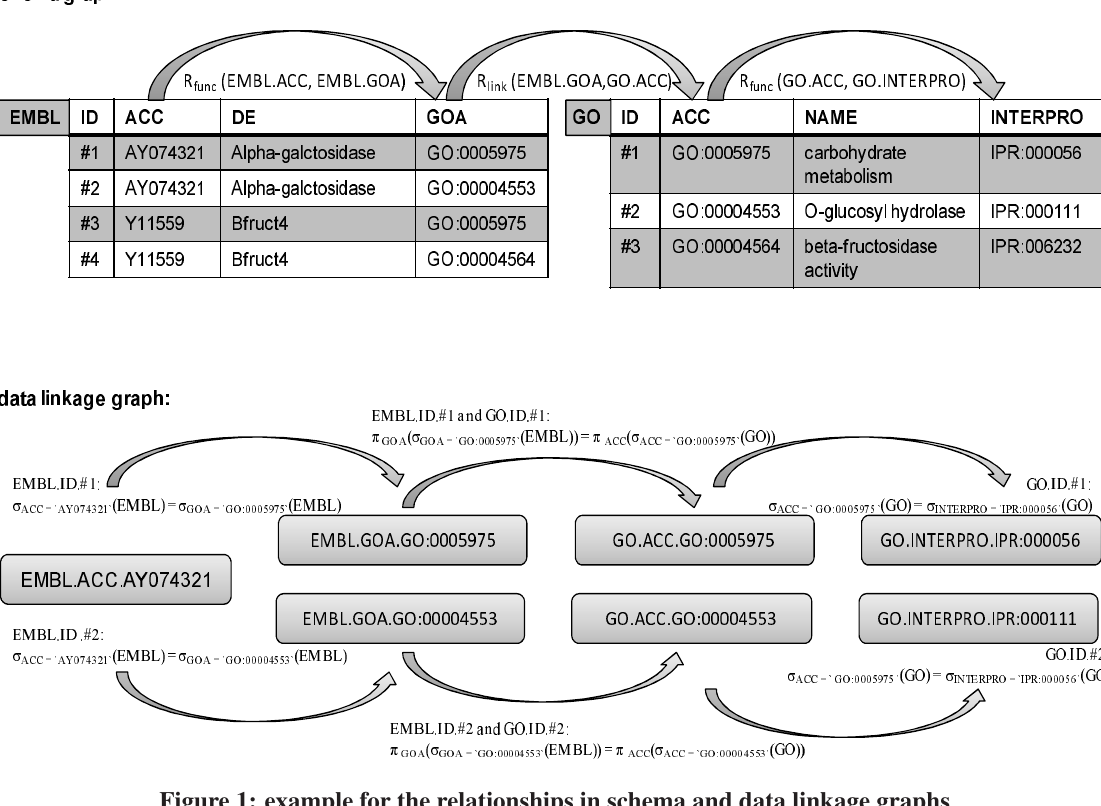
Figure 1: example for the relationships in schema and data linkage